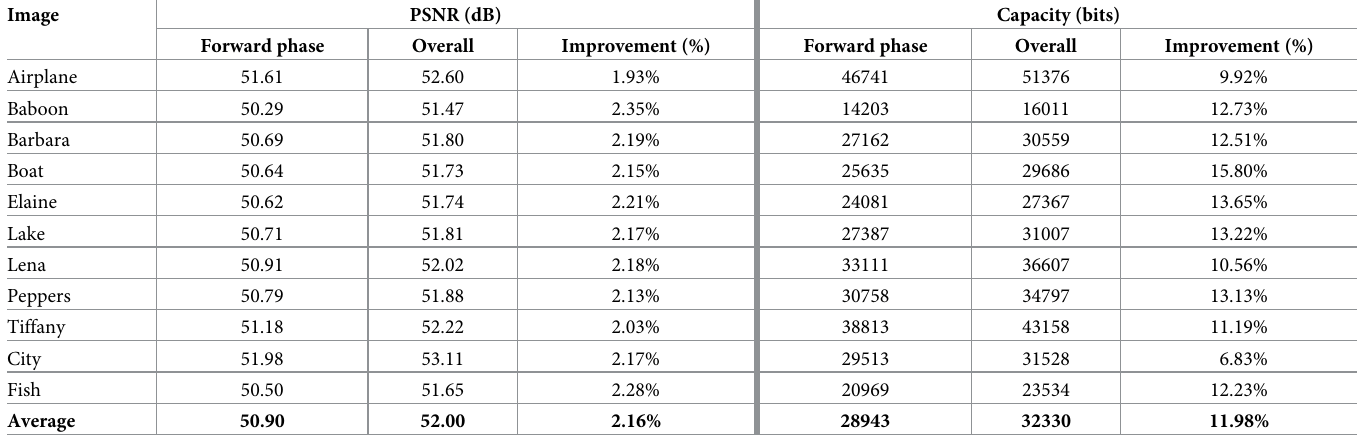
Table 1. Improvement in image quality and capacity for the test